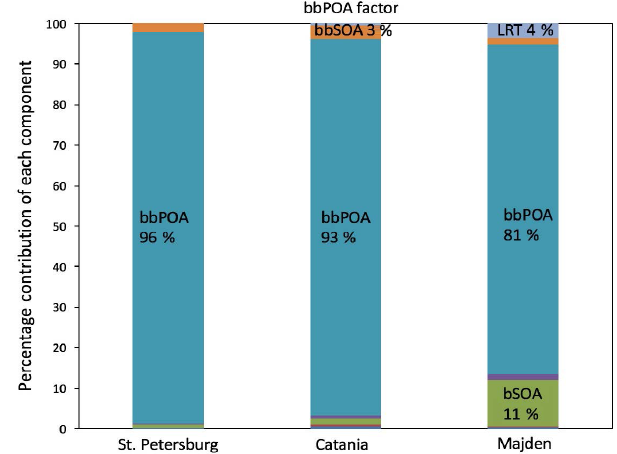
Figure 4. Contribution of each OA component to the PMCAMx- SR bbPOA factor in St. Petersburg, Catania, and Majden during May